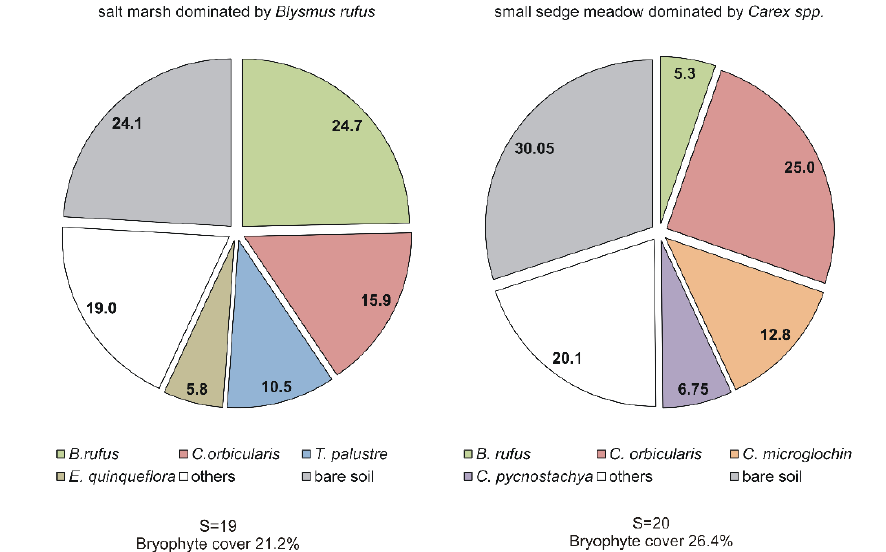
Figure 2. Average cover (%) of the most abundant species in salt marsh dominated by Blysmus rufus (N=13) and saline small sedge meadow dominated by Carex microglochin and Carex orbicularis (N=20). S = number of species